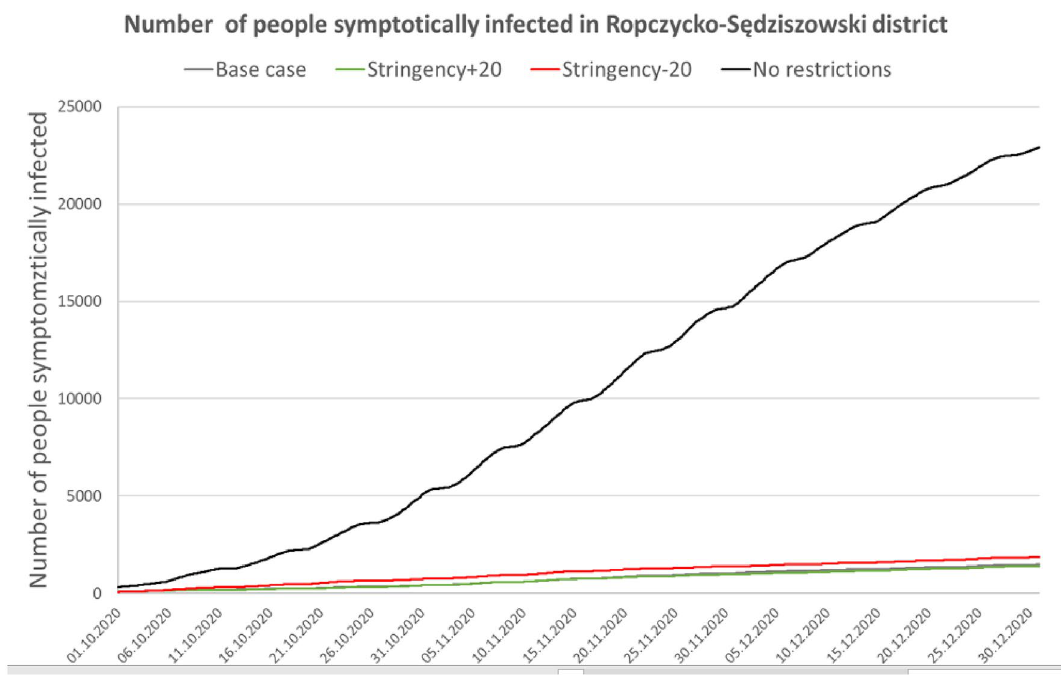
Figure 5. Number of symptomatic infected agents in the Ropczycko-Sędziszowski powiat